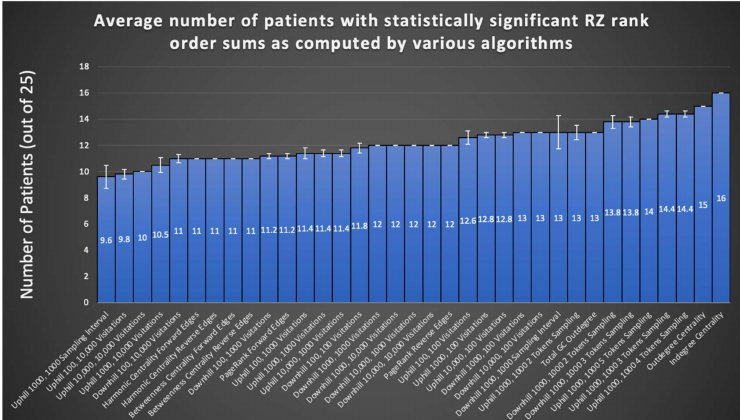
Figure 5. The RZ rank order sums of all algorithms and their variants are displayed here, with total GC outdegree included for comparison. SE bars are shown from sample sizes of five runs for each algorithm. Note the results of in/outdegree centrality algorithms, which exceed that of the total GC outdegree method from the literature while avoiding stochasticity of results found in other tested graph algorithms.